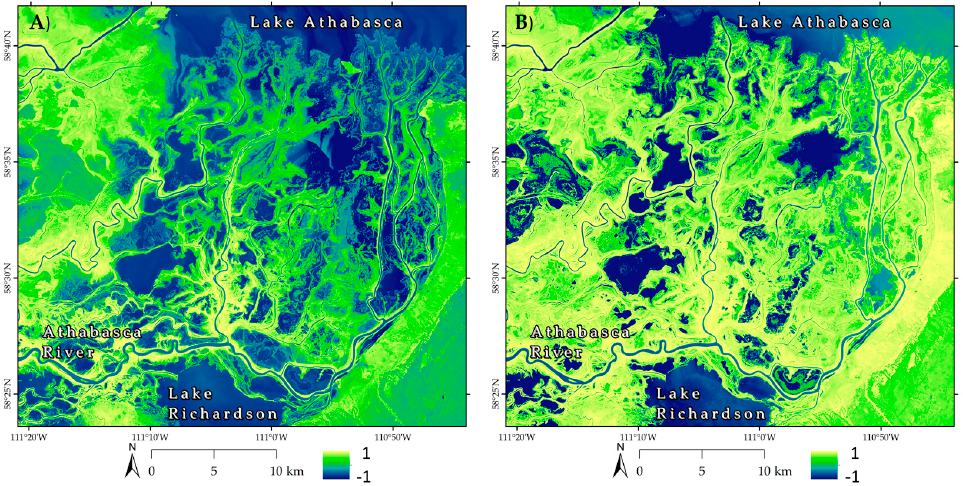
Figure 12. Sentinel-2 NDVI for the eastern portion of the PAD between Richardson Lake and